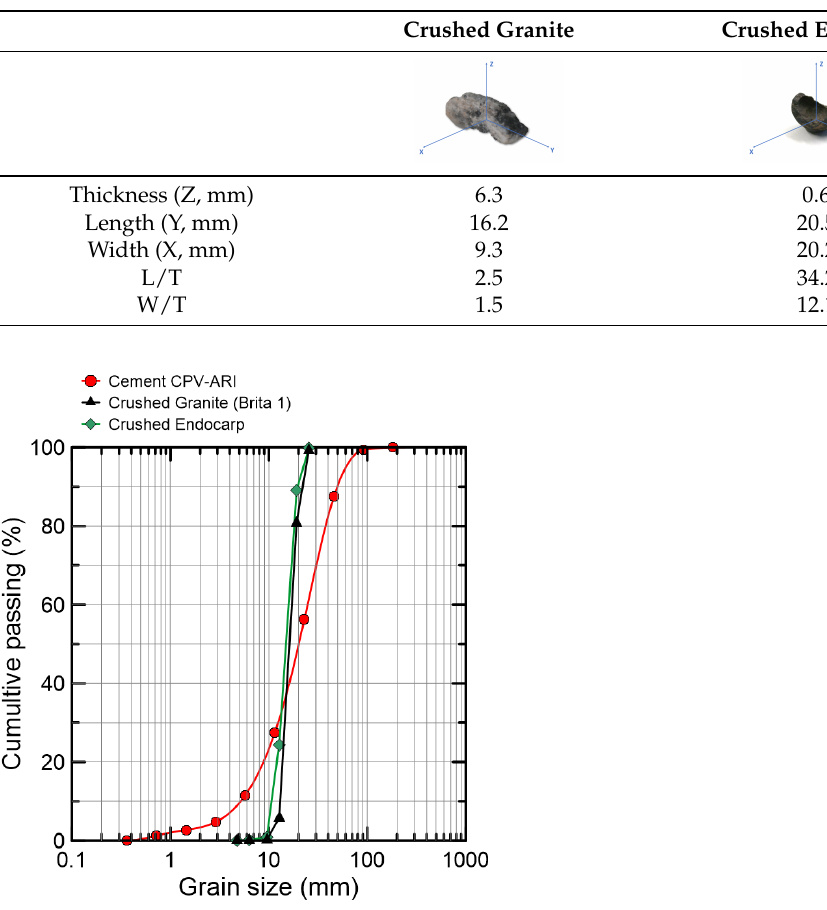
Table 5. Dimensions of the aggregates.